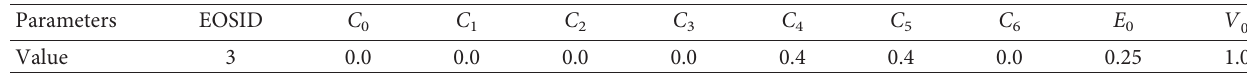
Table 11: Parameters of state equation of air.